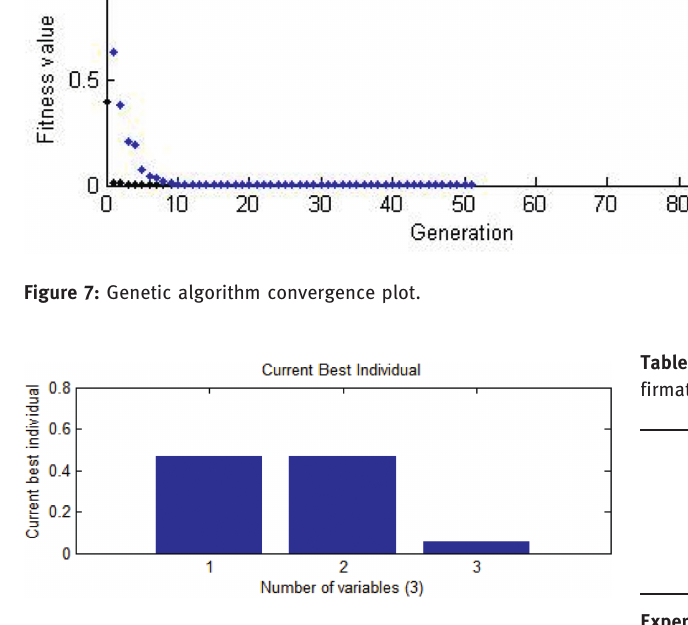
Figure 8: Best individual parameter in GA optimization.